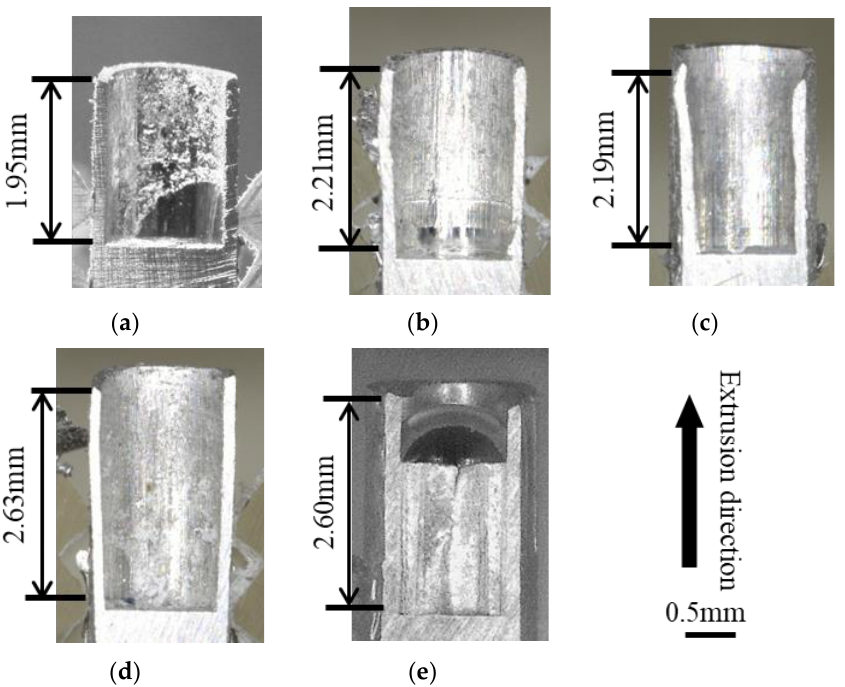
Figure 5. Longitudinal section cross-sectional images of the extrusion: ( a ) mirror surface, ( b ) millimeter-textured, ( c ) 10 μm -textured, ( d ) 5 μm -textured, and ( e ) nanometer-textured punches.